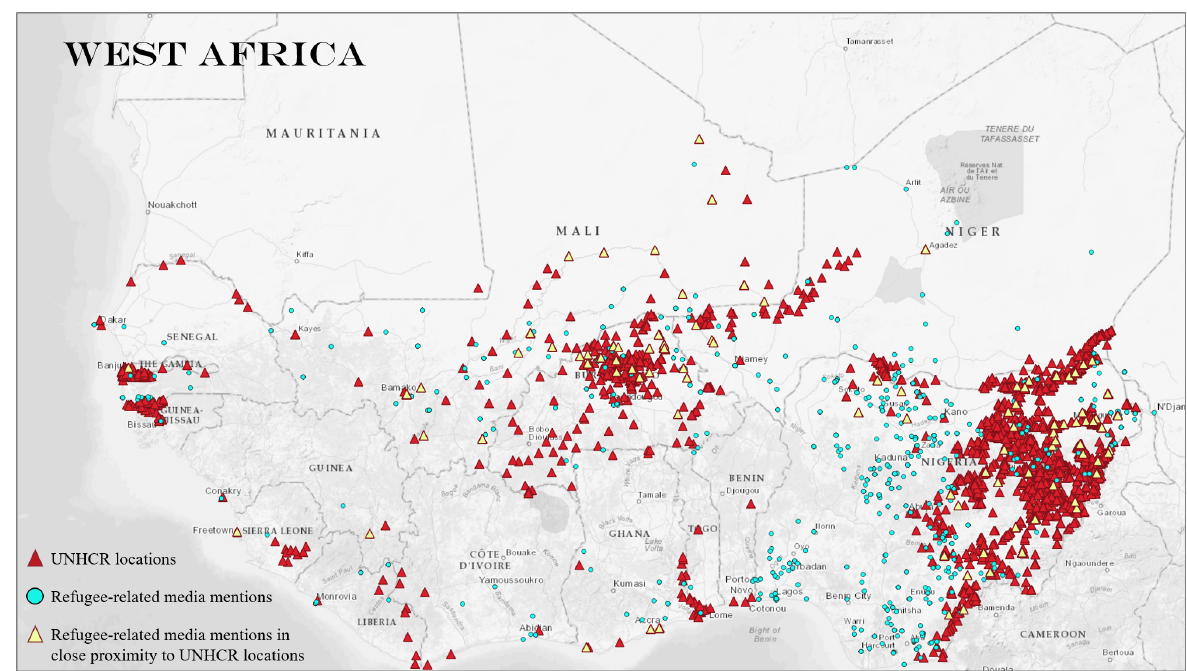
Figure 2. The locations recorded in the UNHCR database (red), the locations mentioned in the news media referring to the refugee crisis (blue), and media mentions in close proximity to the locations recorded in the UNHCR during the time period 12 March–15 September